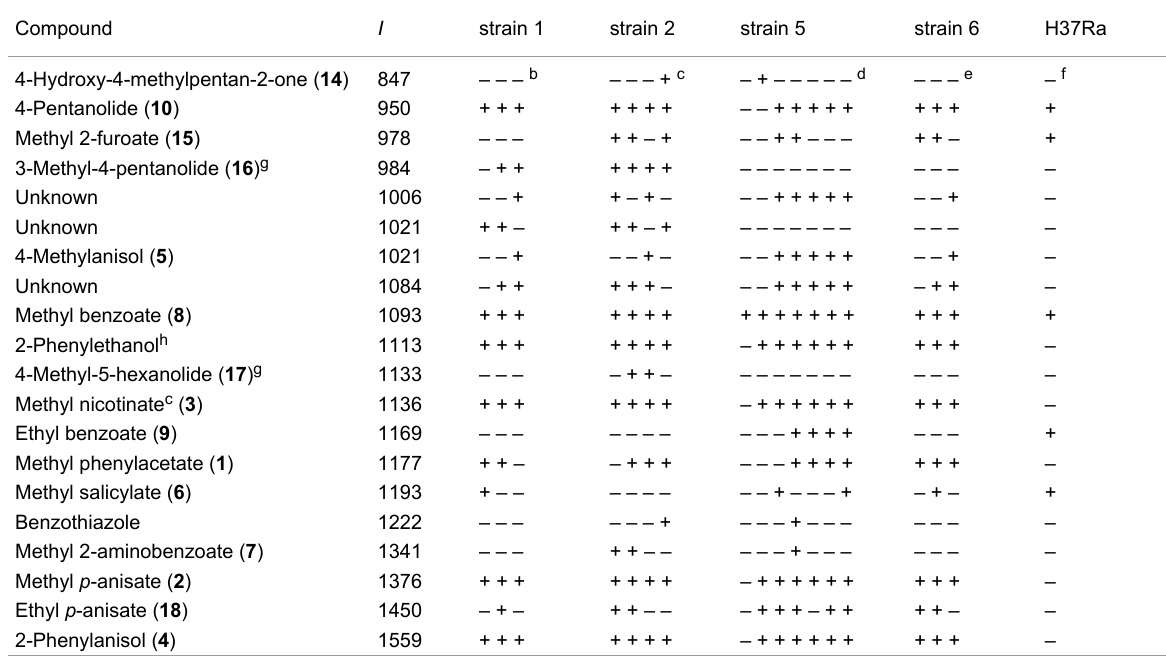
Table 1: Volatiles released by Mycobacterium tuberculosis grown on a 7H11 solid medium. a Compound